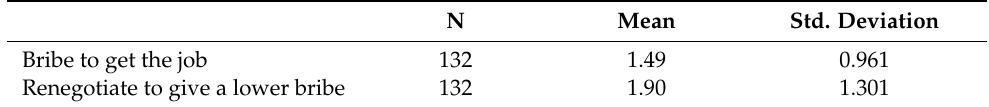
Table 9. Valuers’ response to corruption.